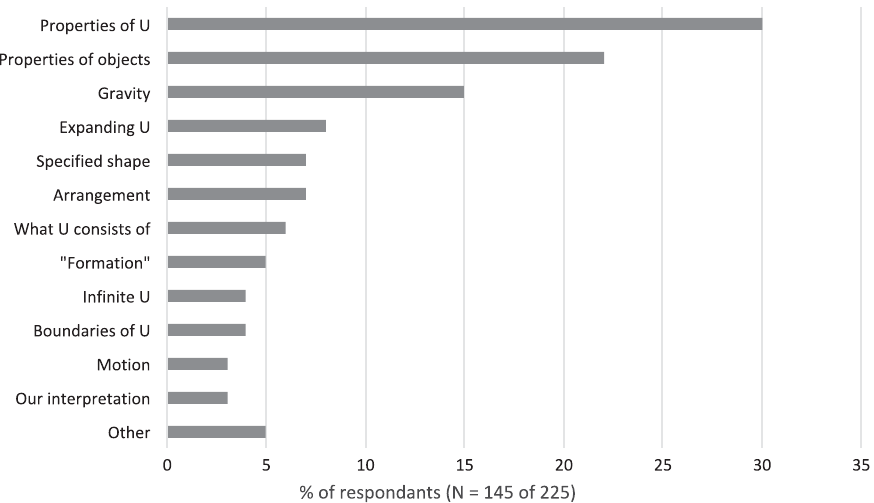
FIG. 7. ASTRO 101 Preinstruction survey responses for What do astronomers mean when they talk about the “ shape ” or “ curvature ” of space (the Universe) ? 6